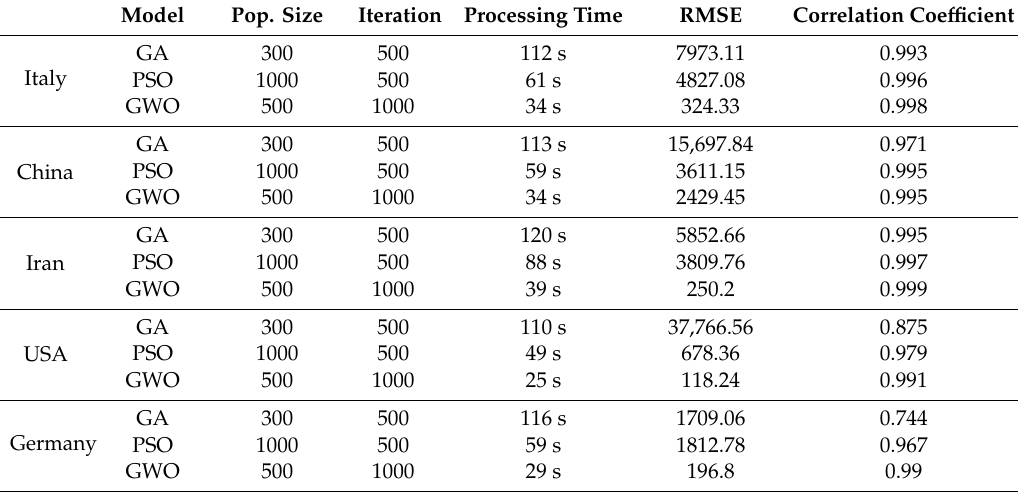
Table 7. Accuracy statistics for the cubic model.